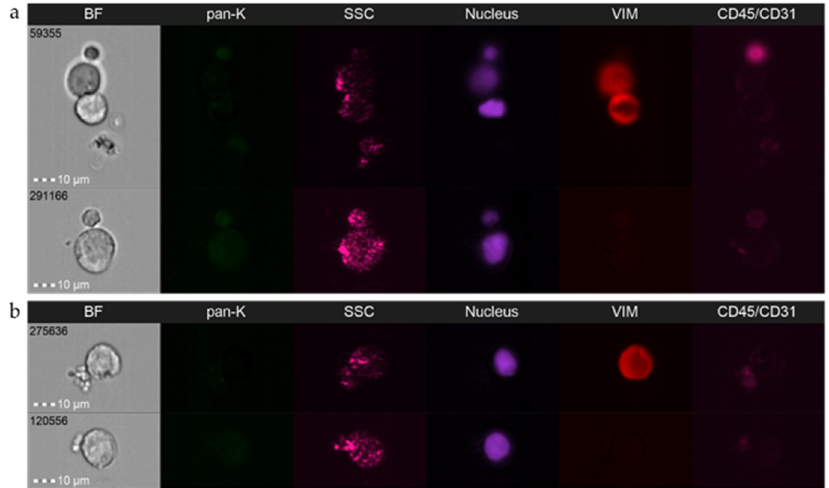
Figure 2. Representative pictures of circulating tumor cells (DAPI(+)CD45/CD31( − )) isolated from prostate cancer patients interacting with ( a ) normal cells (CD45/CD31(+)) and ( b ) platelets performed using imaging flow cytometry. BF—brightfield; pan-K—pan-keratins; SSC—side scatter; Vim—vimentin; CD45/CD31—leukocyte/endothelial cell marker. Amnis ® ImageStream ® X Mk II (Luminex, Austin, TX, USA), objective 40 × .